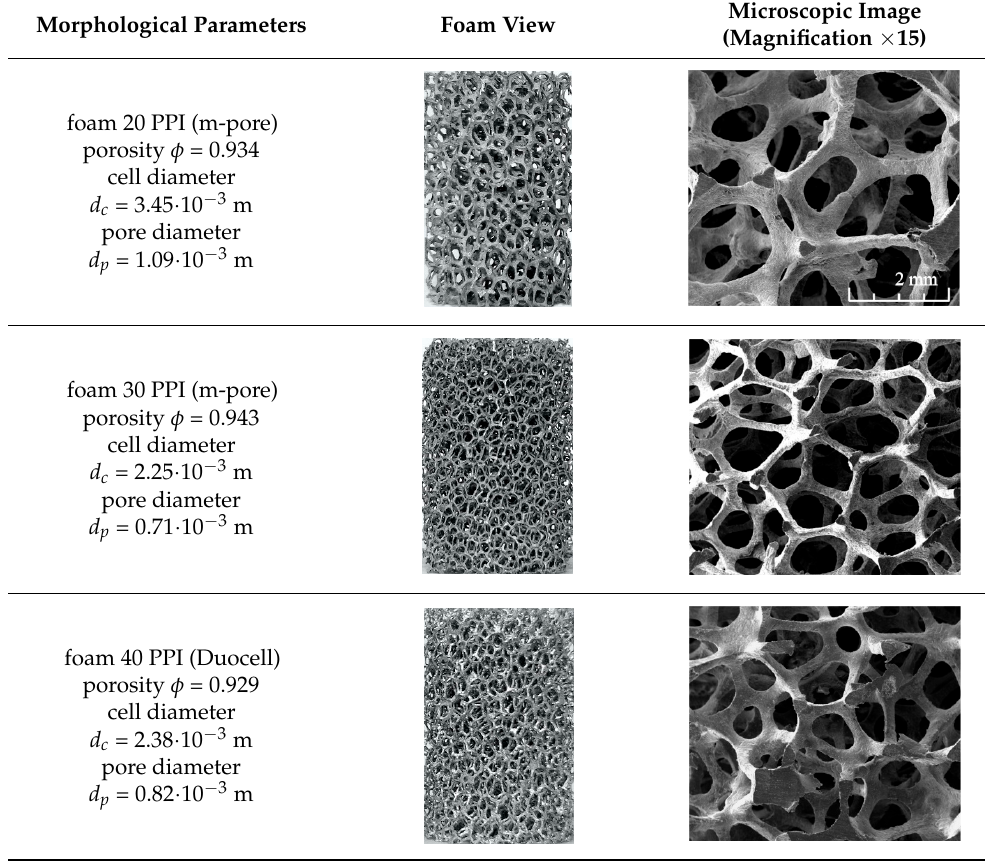
Table 4. Characteristics of aluminium foams.